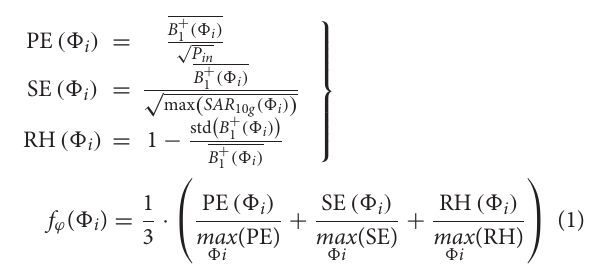
TABLE 1 | The total number of phase sets for each of the four coil groups (1-, 2-, 3-, and 4-element arrays) as well as the total number of simulation setups are